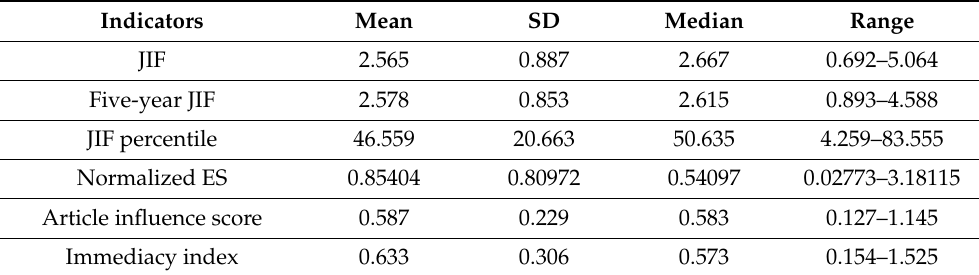
Table 1. Journal impact factor and other key metrics of the included journals.